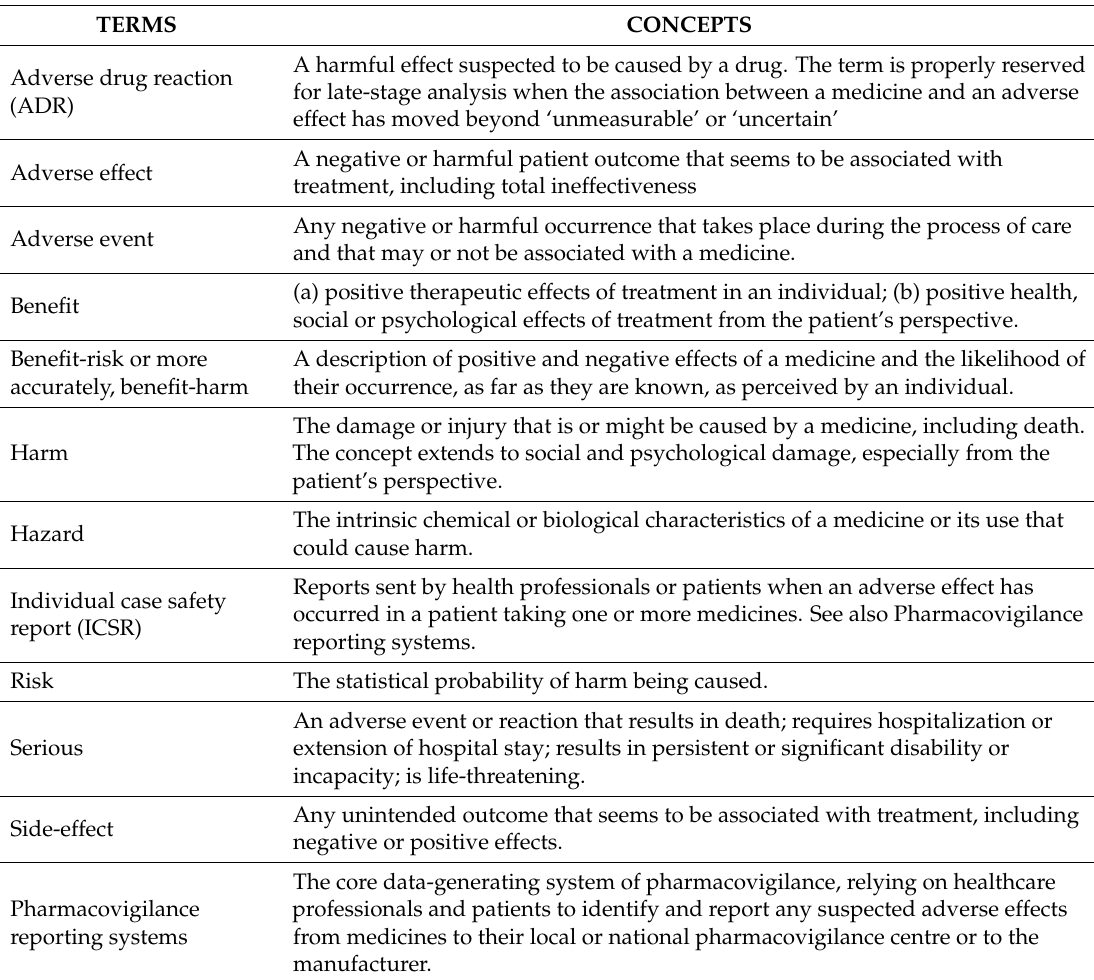
Table 1. List of most common terms and concepts in pharmacovigilance (modified from the Uppsala Monitoring Centre. WHO Programme for International Drug Monitoring